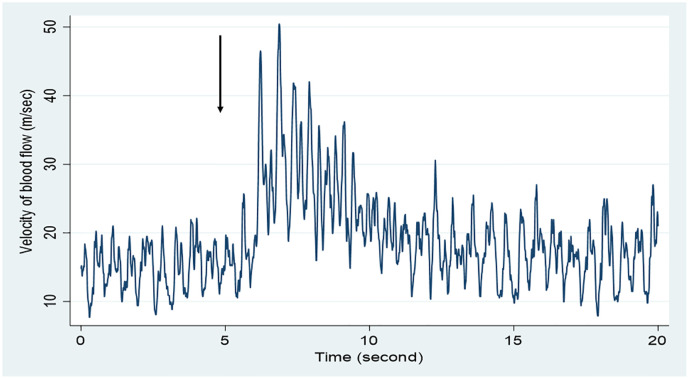
Change in blood flow velocity after administering a bolus of normal saline.A bolus of normal saline was administered via a peripheral intravenous line from the point of 5 seconds (arrow).